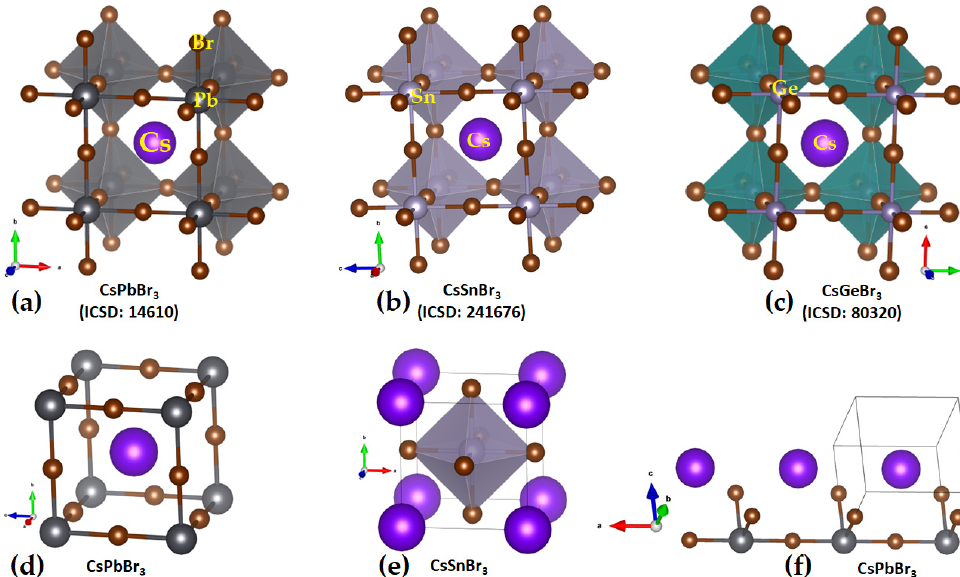
Figure 5. Top: the mixed polyhedral and ball-and-stick models of the cubic ( Pm- 3(cid:3364) m) phase crystal structures of cesium tetrel bromide perovskites, showing the corner-sharing octahedra for ( a ) CsPbBr 3 , ( b ) CsSnBr 3 , and ( c ) CsGeBr 3 . Bottom: ( d ) the ball-and-stick model of the cage-like structure of CsPbBr 3 ; ( e ) the nature of arrangement of Cs cations on each [SnBr 3 ] − face of the SnBr 64 − octahedra in CsSnBr 3 ; ( f ) the 1D array of CsPbBr 3 . The ICSD reference in parentheses is shown in ( a – c ).